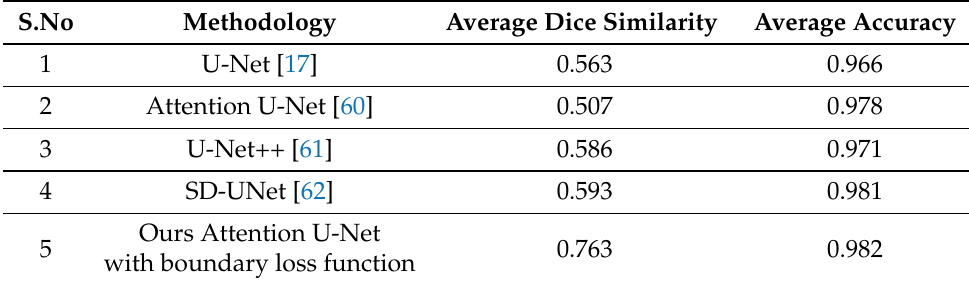
Table 3. Comparison analysis of different segmentation